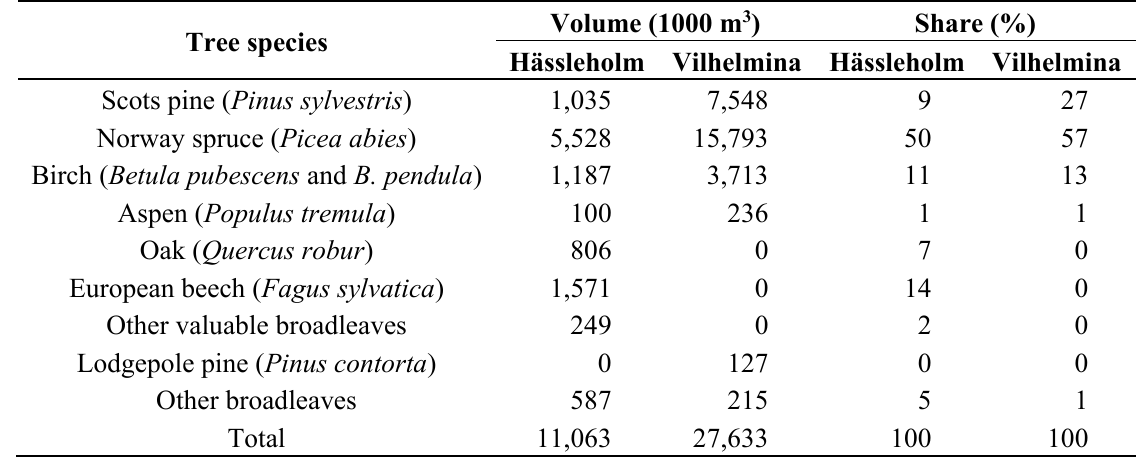
Figure 2. Initial age class distribution in Hässleholm ( left ) and Vilhelmina ( right ). NB: different scales on y -axes. Table 3. Initial tree species distribution in Hässleholm and